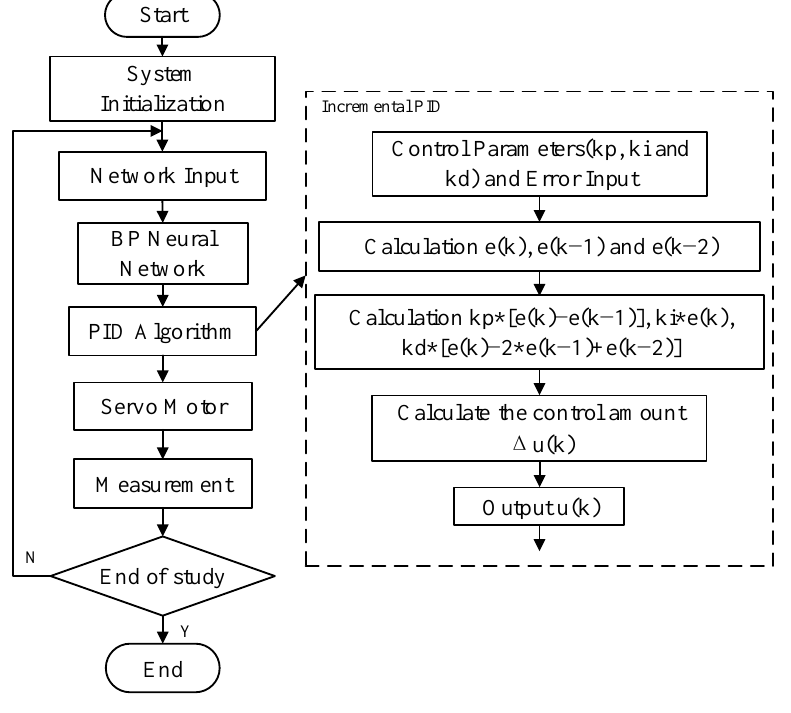
Figure 2. Flow chart of closed-loop control